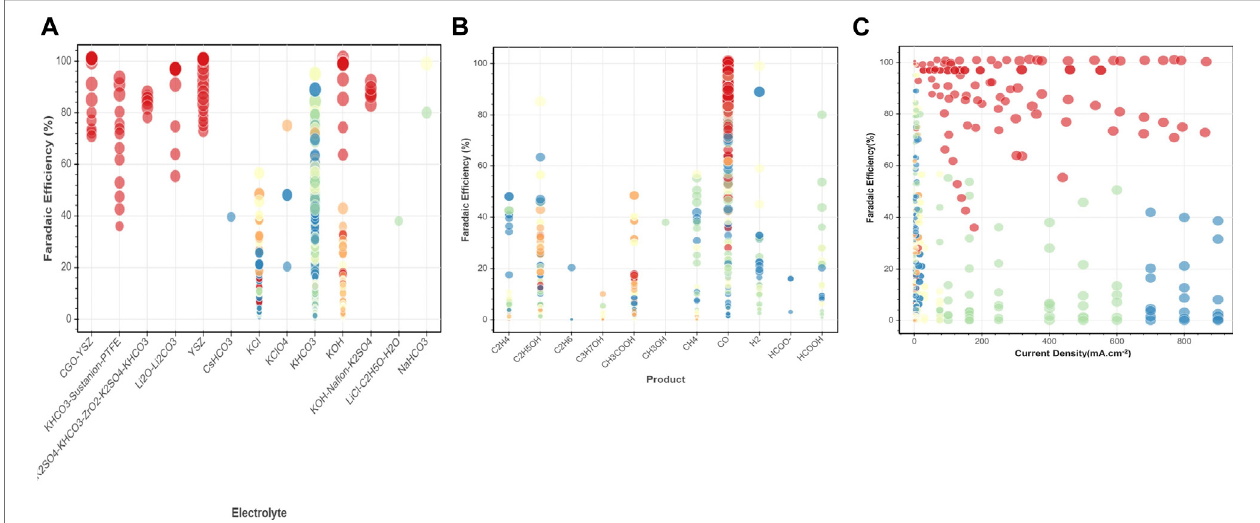
FIGURE 6 | Binary correlations among key attributes (A) FE-electrolyte, (B) FE-product, (C) FE-current density for sample extracted datasets of electrocatalyst materials at low and high temperature.